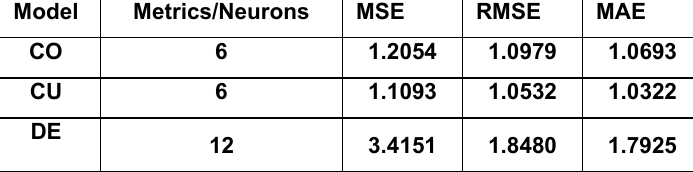
Table.8 Performance Error Metrics resulted by COCUDE model